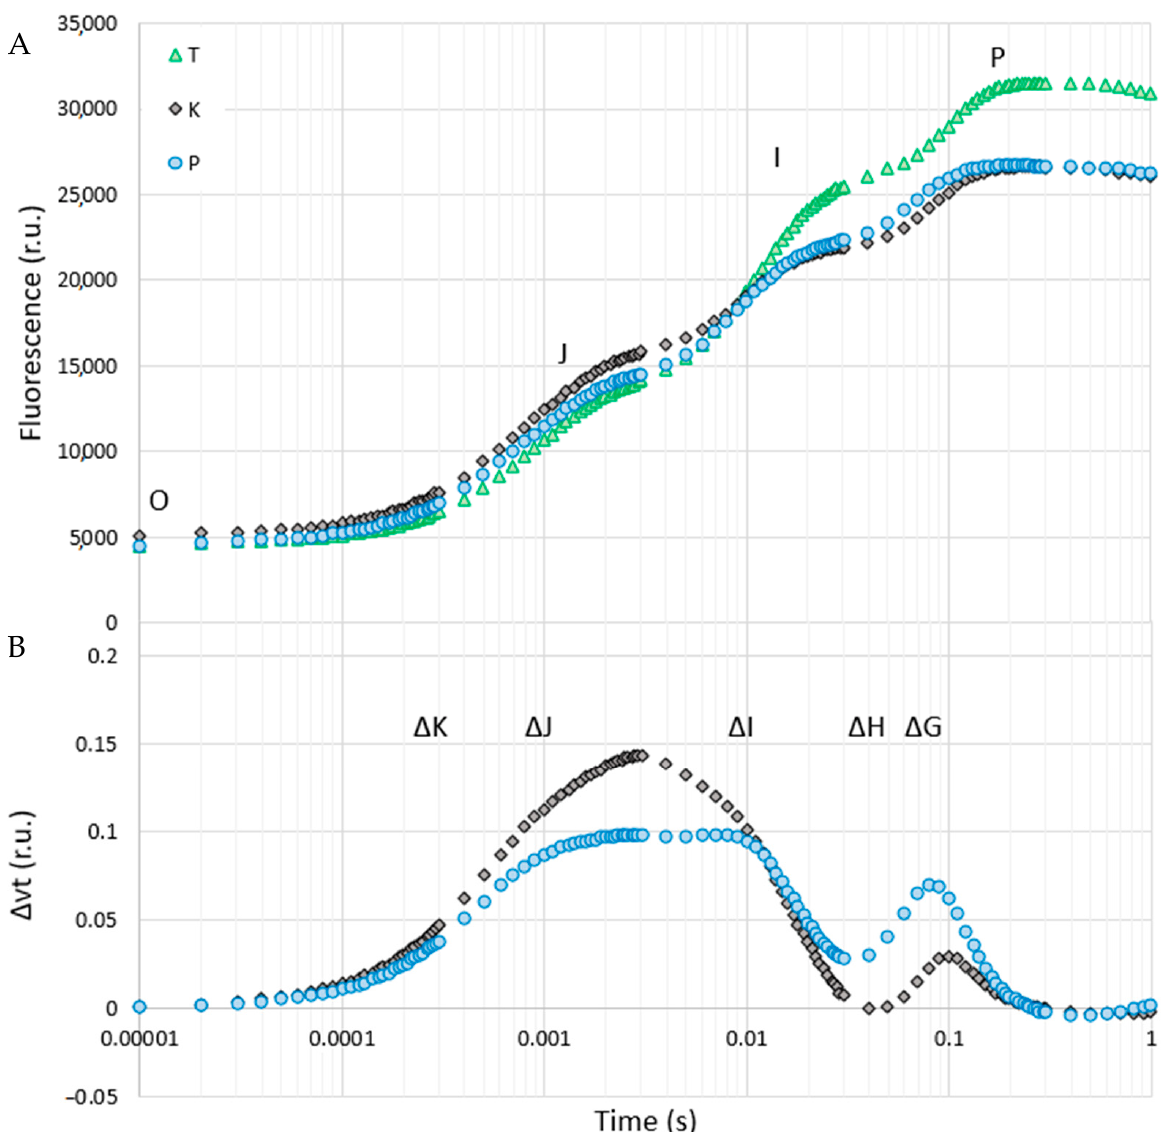
Figure 2. Chlorophyll a fluorescence induction curves of the silver birch ( Betula pendula ) from vari- ous sites ( A ) and differences between the populations studied on the relative variable fluorescence ( Δ Vt = ((Ft − F 0 )/Fv) − Vt_control) ( B ). For Δ Vt analysis, the fluorescence of trees from Tychy was the reference and was equal to 0. Values are means (n = 10). Abbreviations: T—reference population from Tychy; K—birch population from post-coal mine spoil heap; P—birch population from post- smelter spoil heap; O, J, I, P—points characterising the course of the fluorescence curve, including the minimum and maximum chlorophyll fluorescence for a given population. Δ K—peak informing about the potential damage of the Oxygen-Evolving Complex; Δ J—peak describing the level of po- tential damage of the ubiquinone pool; Δ I—peak corresponding to the accumulation of reduced primary quinone; Δ H and Δ G—peaks describing a decrease in activity of the final electron acceptors in PSI, r.u. – relative units.